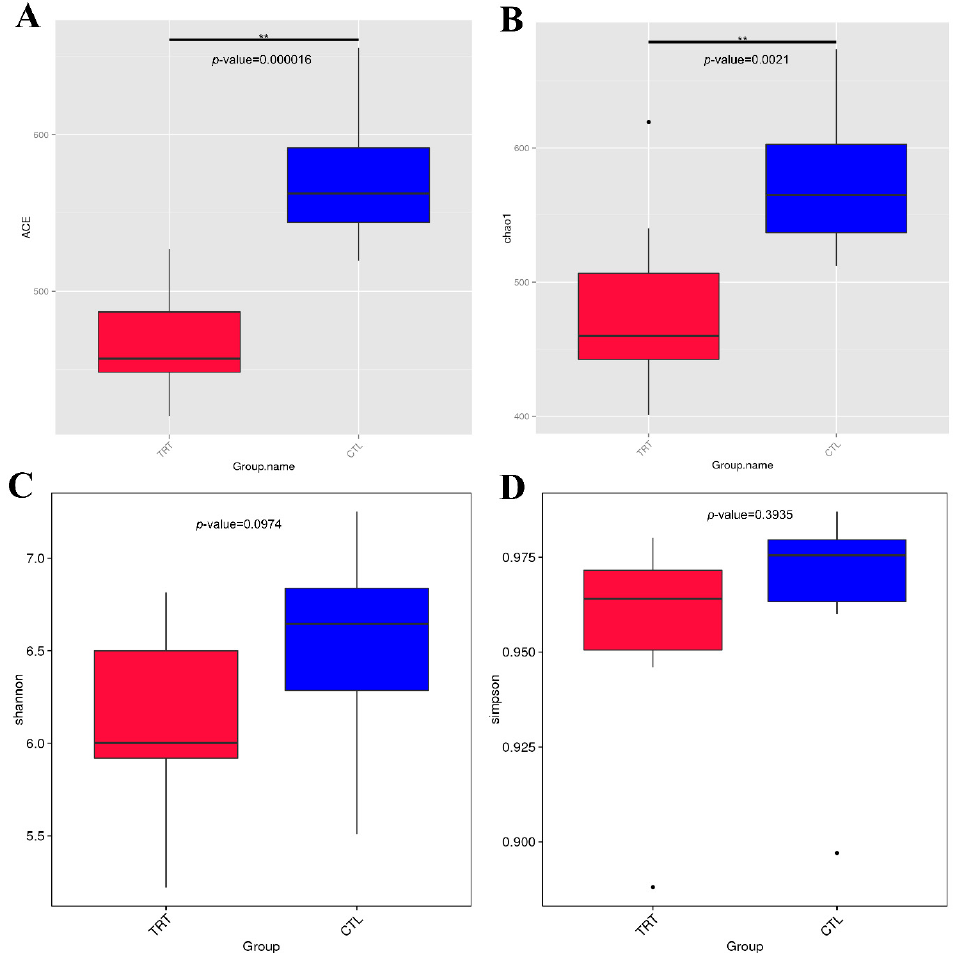
Figure 2. Dietary silymarin supplementation modulated the microbiota alpha diversity index of lactation sow, including richness (ACE, Chao 1 index) and diversity (Shannon, Simpson index). ( A ) ACE index: p < 0.01. ( B ) Chao 1 index: p < 0.01. ( C ) Shannon index: p = 0.097. ( D ) Simpson index: p = 0.39. n = 10. CTL, sow fed the basal diet; TRT, sow fed basal diet with silymarin 40 g/d from late gestation to lactation. ** are significantly different ( p <